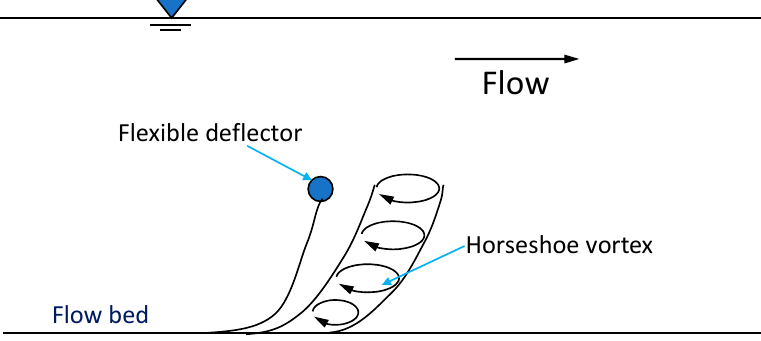
Figure 7. Velocity vectors at different x − y planes: ( a ) z = 0.180 m, ( b ) z = 0.099 m, ( c ) z = 0.019 m.